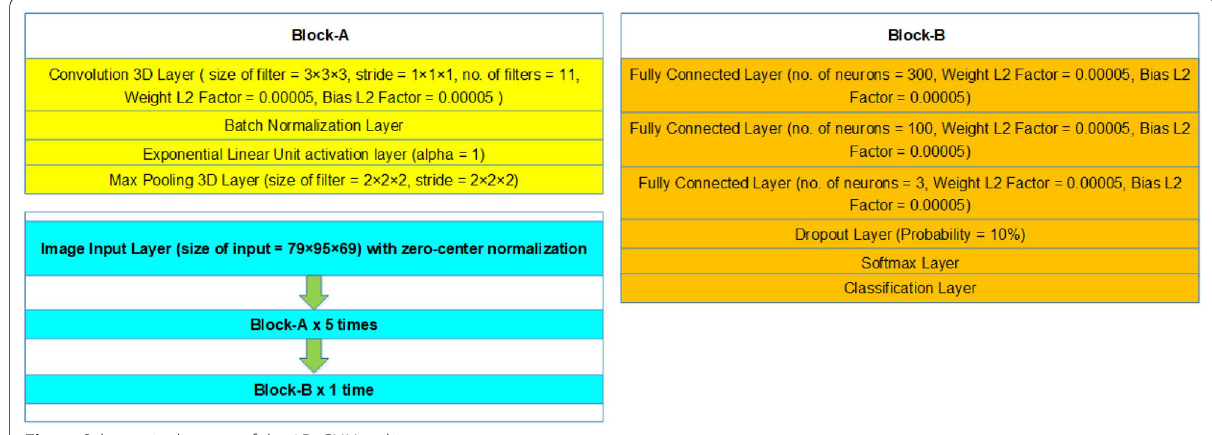
Fig. 1 Schematic diagram of the 3D‑CNN